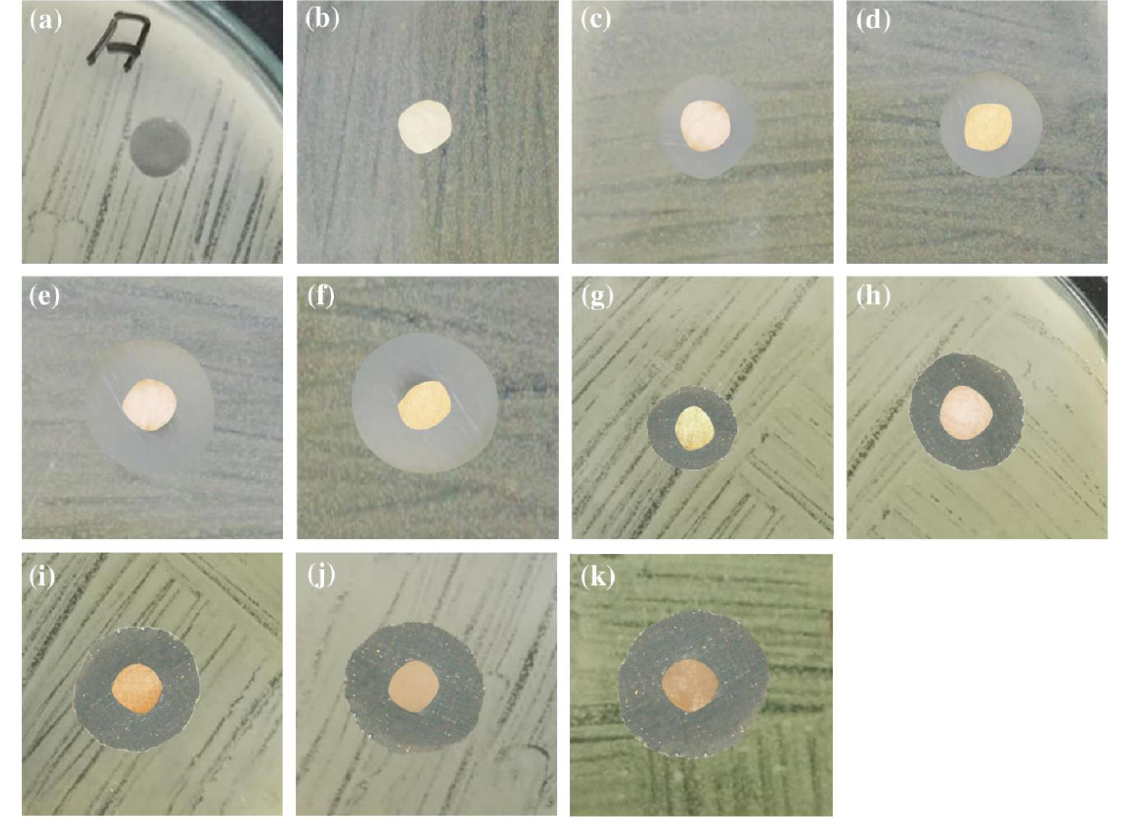
Figure 7. Antibacterial activities against S. aureus by: ( a ) blank; ( b ) pristine PVA; ( c ) 3% Ag–NPs(C)–